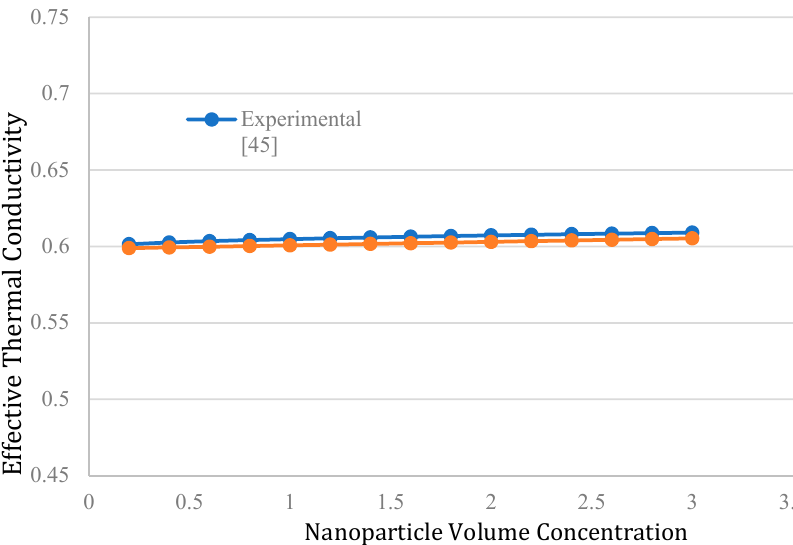
Figure 3. The comparison of the experimental data and predicted effective thermal conductivity by the proposed correlation against the NP volume concentration.